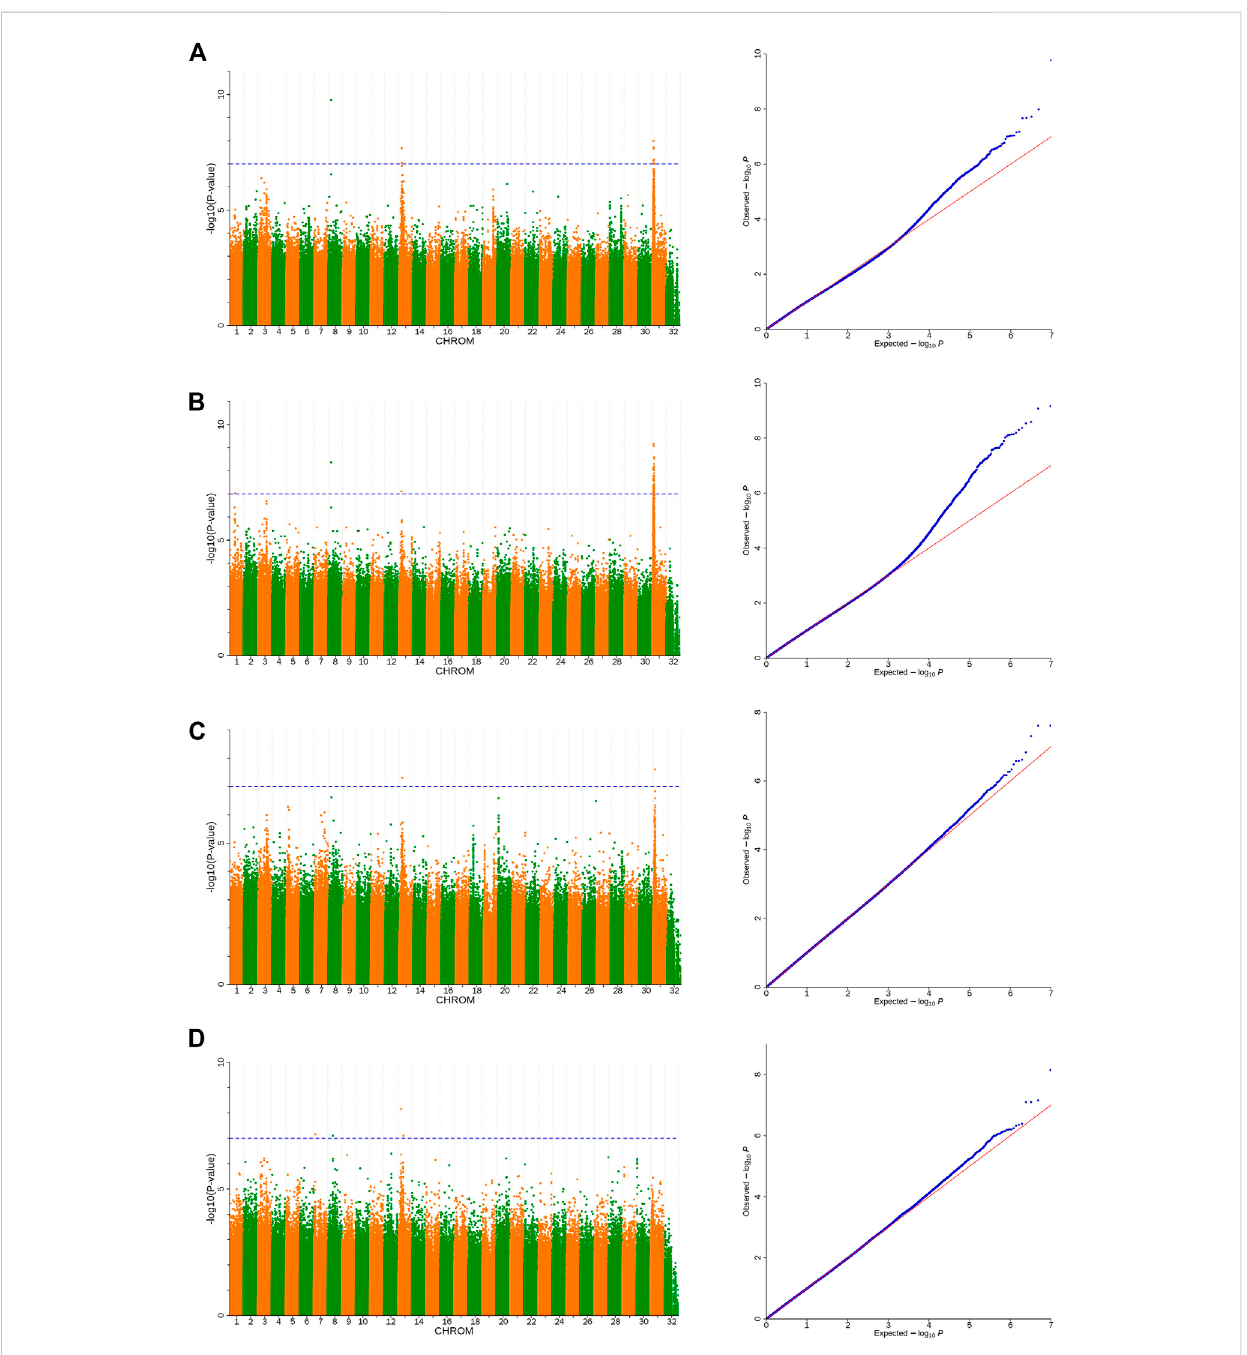
FIGURE 3 ManhattanandQ-Qplotsofbodysizetraits (A) .Bodyheight, (B) .Bodylength, (C) .Chestcircumference, (D) .Shingirth).Signi fi cant p -valuethreshold set at p = 10 − 7 . A total of 16 signi fi cant SNPs are labeled at the top of the Manhattan plot (left). Q-Q plots are displayed as scatter plots of observed and expected log p -values